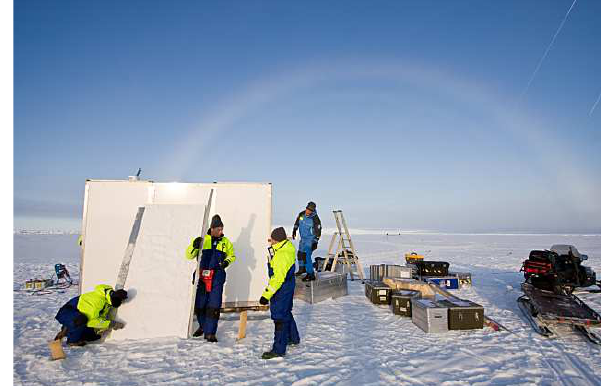
100 Relative Humidity (%) Fig. 4. Profiles of temperature and relative humidity with respect to liquid corresponding to the case shown in Figure 3.